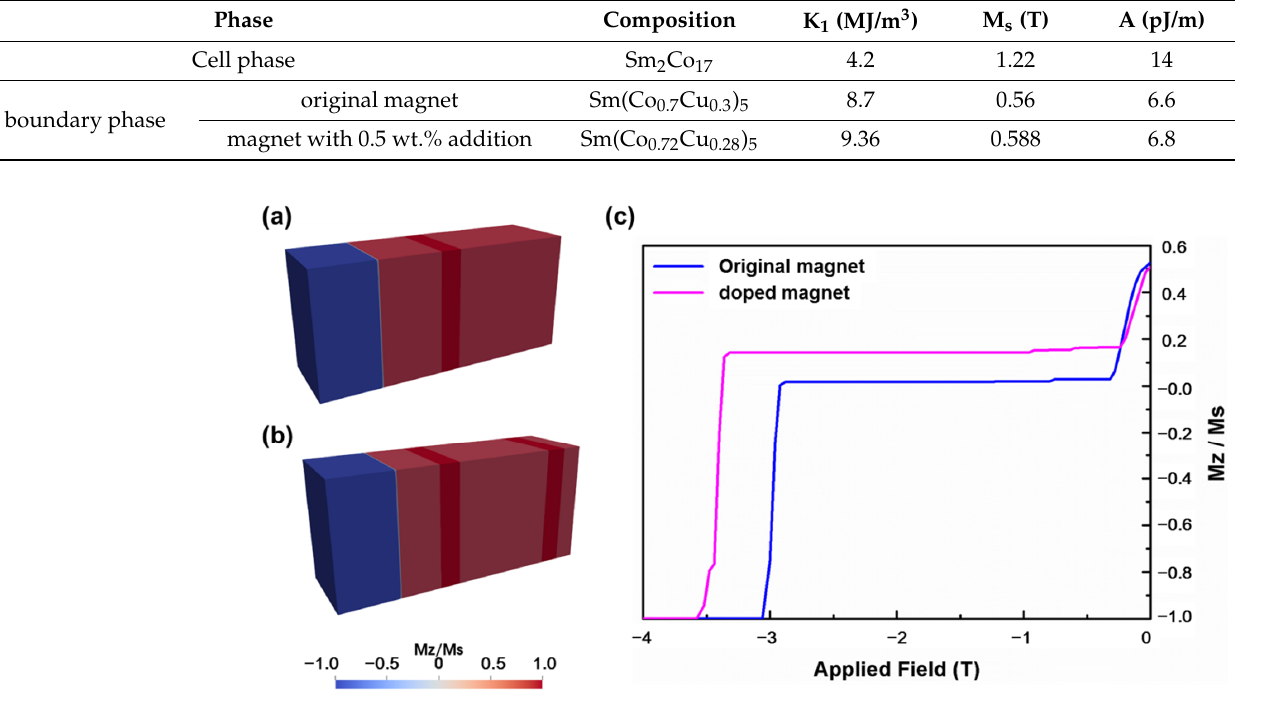
Figure 8. ( a ) Micromagnetic model with a cell boundary, ( b ) micromagnetic model with 2 cell boundaries, ( c ) theoretical demagnetization curves. Table 2. Composition corresponding to the cell phase and cell boundary phase in the original mag- net and the magnet with 0.5 wt.% addition and its K 1 , M s and A.